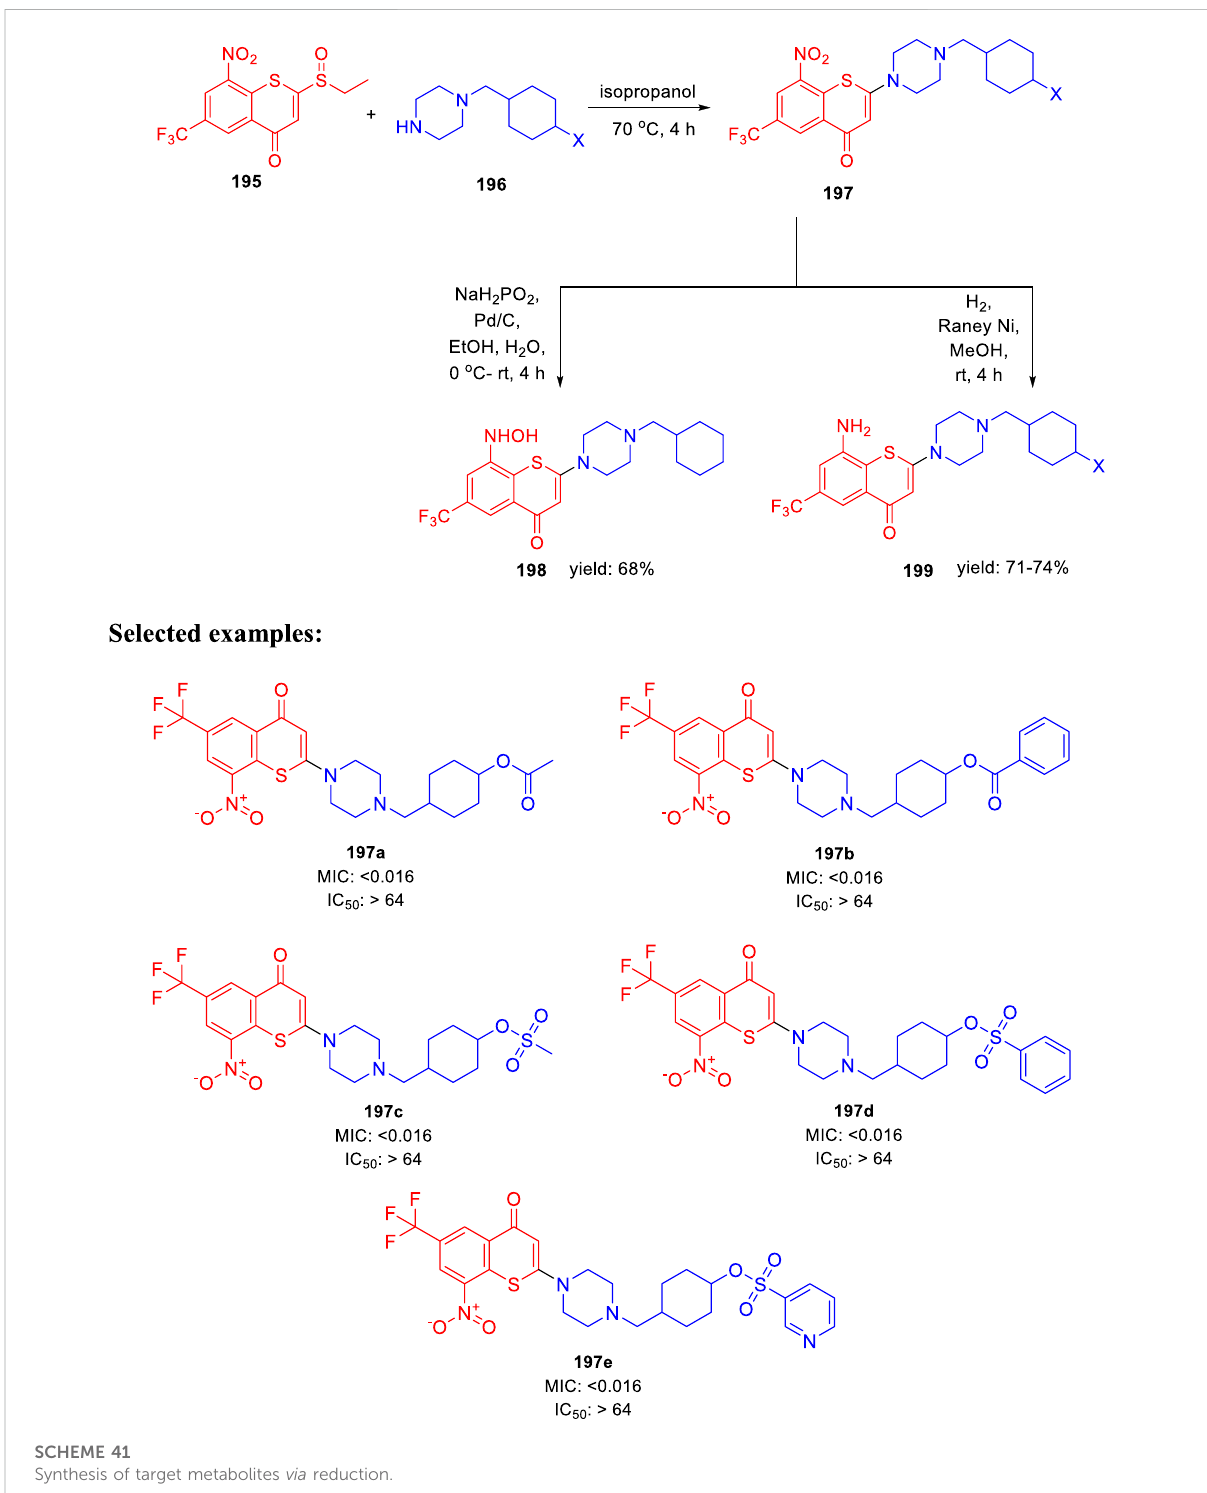
SCHEME 41 Synthesis of target metabolites via